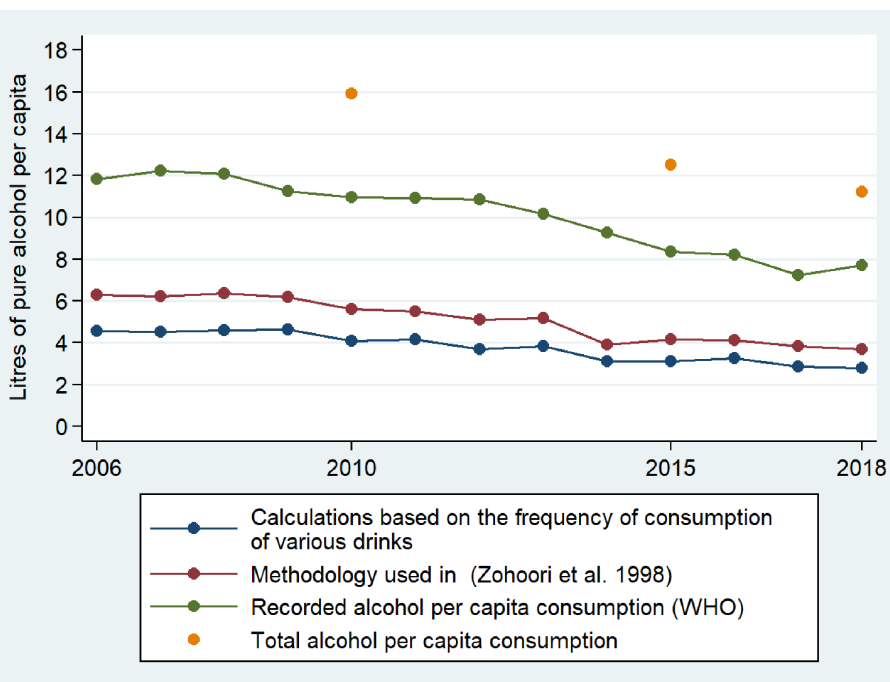
Figure 2. Estimates of alcohol consumption in Russia, liters of ethanol per capita, 2006-2018. Source : author’s calculations based on the WHO data (see http://apps.who.int/gho/data/node.main. A1022?lang=en; date of reference